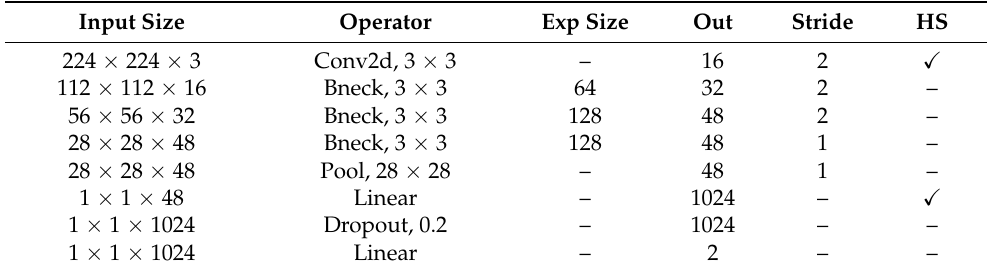
Table 1. Proposed model structure in the